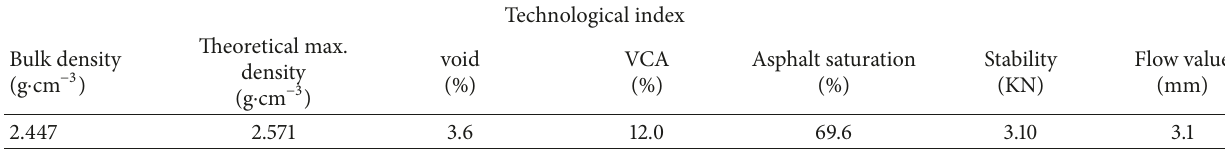
Table 14: Marshall technological index of ATB-25.